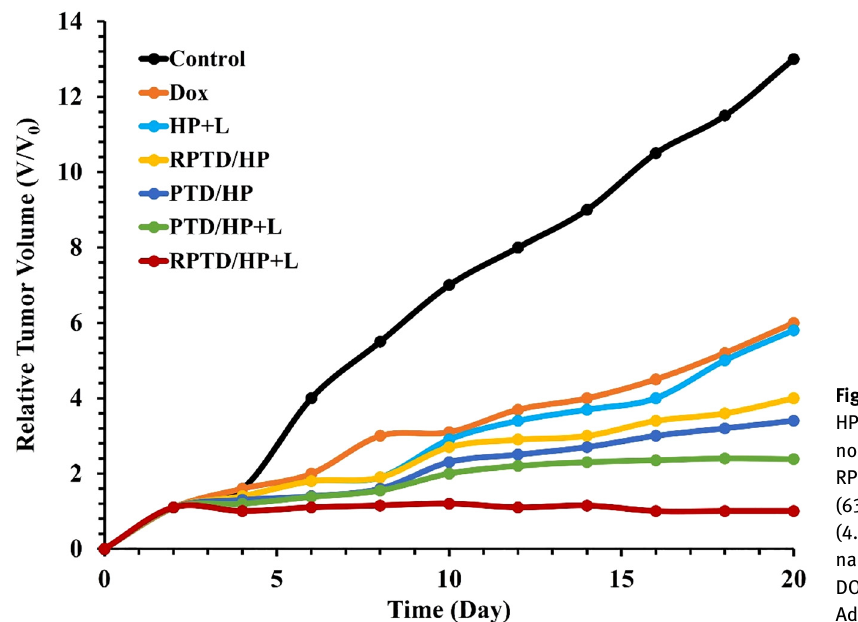
β (Figure 17(A)). Due to their lower expression of α , v 3 MCF-7 cells exhibited an inferior fl uorescence as compared to HUVEC and 4T1 cells. The cytotoxicity studies showed that iRGD-ICG-LPs were biocompatible. Under laser illu- mination, iRGD-ICG-LPs and ICG-LPs exhibited a stronger cytotoxic effect than ICG alone ( P < 0.01) at thesame dose of ICG. The amount of 1 O produced without light, but in 2 presence of iRGD-ICG-LPs alone, was 1.91 times smaller than with iRGD-ICG-LPs excited by laser at 480 nm. The coupling of iRGD with ICG-LPs induced a very important PDT-PTT effect, thus demonstrating the speci fi c targeting of the tumors. Using the luminescence of ICG, the in vivo results showed a stronger accumulation of the NPs in the tumors than that in the liver, spleen and other organs (Figure 18(A) – (C)). After light illumination of the cells exposed to iRGD-ICG-LPs, the growth of the tumor was suppressed ( P < 0.01) (Figure 17(B)). For these NPs, the amount of the generated ROS was 3.82 times greater than that produced in the tumors treated with PBS alone (control).